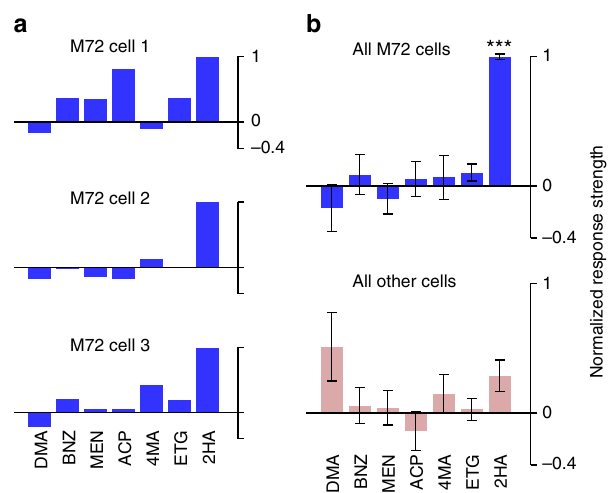
Fig. 7 Odor-evoked rate responses display stereotypy also only for the strongest ligand. a Odor response pro fi les of three M72-MT cells, calculated as the mean change in spike count over the duration of the entire fi rst sniff. Each cell ’ s responses are normalized such that 0 (horizontal line) is the spike count during baseline (air) and 1 is the maximum spike count across odors. b Odor response pro fi les averaged across the population; for M72-MT cells (top) and generic MT cells (bottom). M72-MT response is signi fi cantly higher than the generic MT response only for 2HA (Wilcoxon signed-rank test). Error bars =